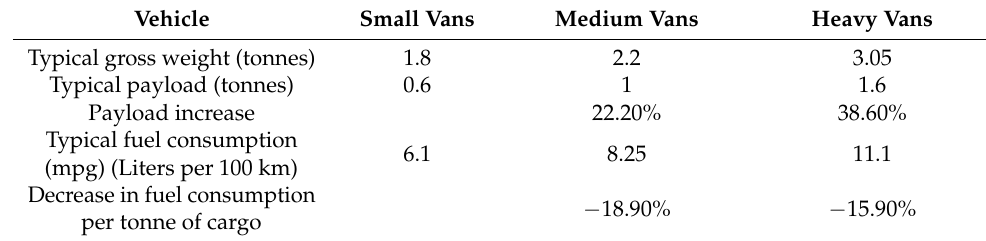
Table 3. Summary of the typical size, weight and fuel efficiency attributes of vans. Vehicle Small Vans Medium Vans Heavy Vans Typical gross weight (tonnes) 1.8 Typical payload (tonnes) 0.6 Payload increase 22.20% Typical fuel consumption 6.1 8.25 11.1 Decrease in fuel consumption per tonne of